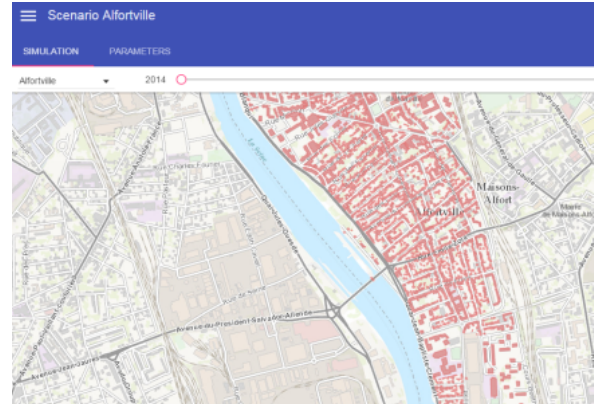
Figure 3. Screenshot of Alfortyville city on ISRI map